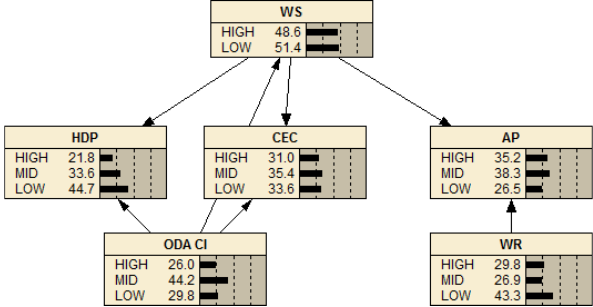
Fig. 2. WS general model, DAG shows the relationships between the WS and pillars and initial probabilities computed.